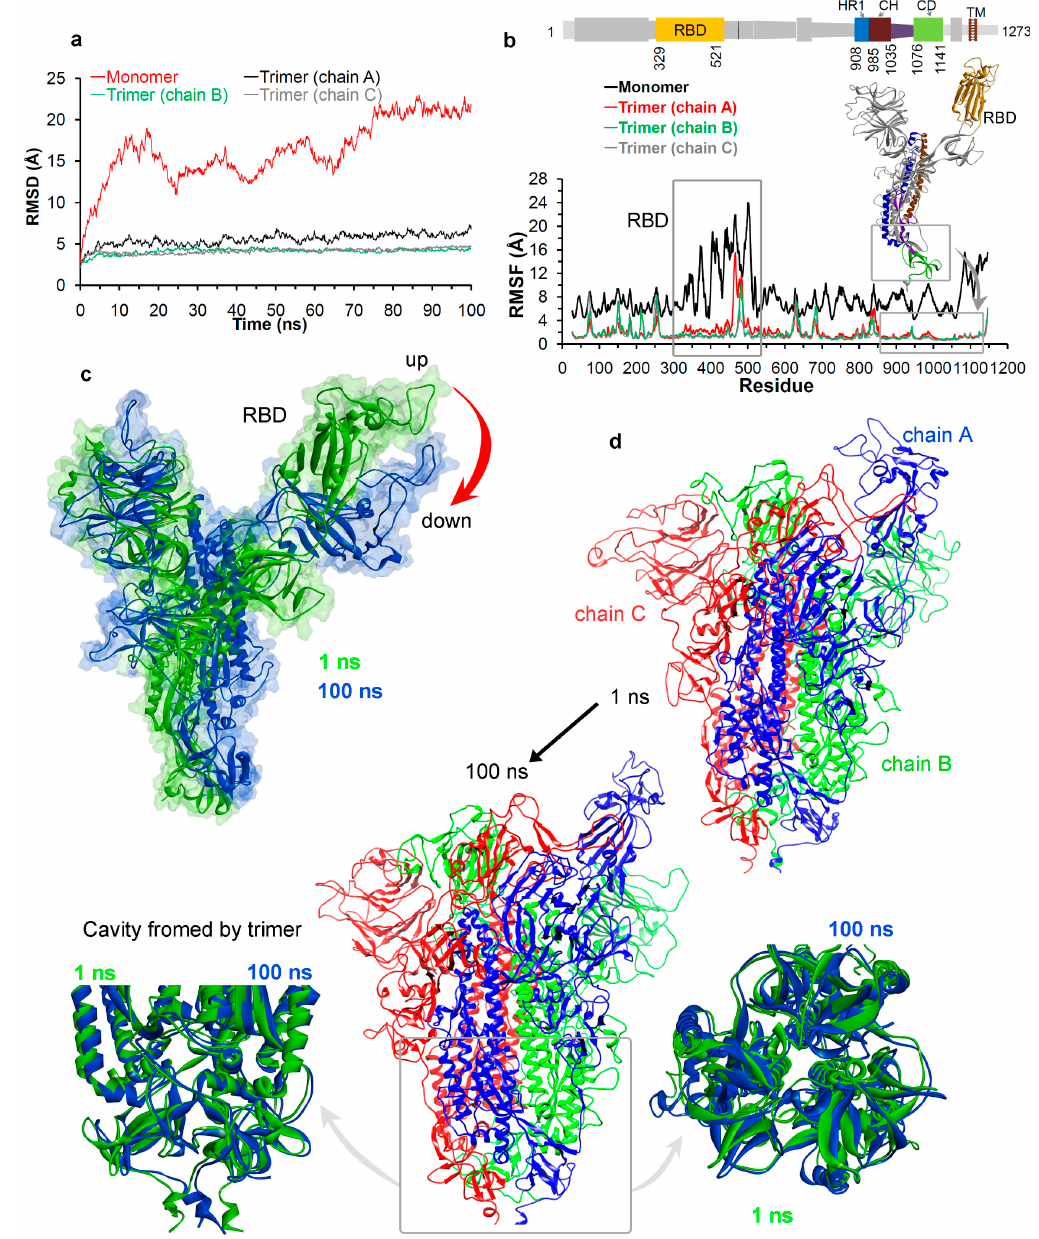
Figure 3. Conformational dynamics of the SARS-CoV-2 spike glycoprotein. ( a , b ) RMSD and RMSF of the monomeric and trimeric forms. ( c ) The “up” and “down” state traced during the MD simulations of the monomeric form. ( d ) The conformation dynamics of homotrimer spike protein, as well as the highlighted cavity formed by the trimer state and its evolution over 100 ns of the MD simulation. RMSD, root mean square deviation; RMSF, root mean square fluctuations; MD, molecular